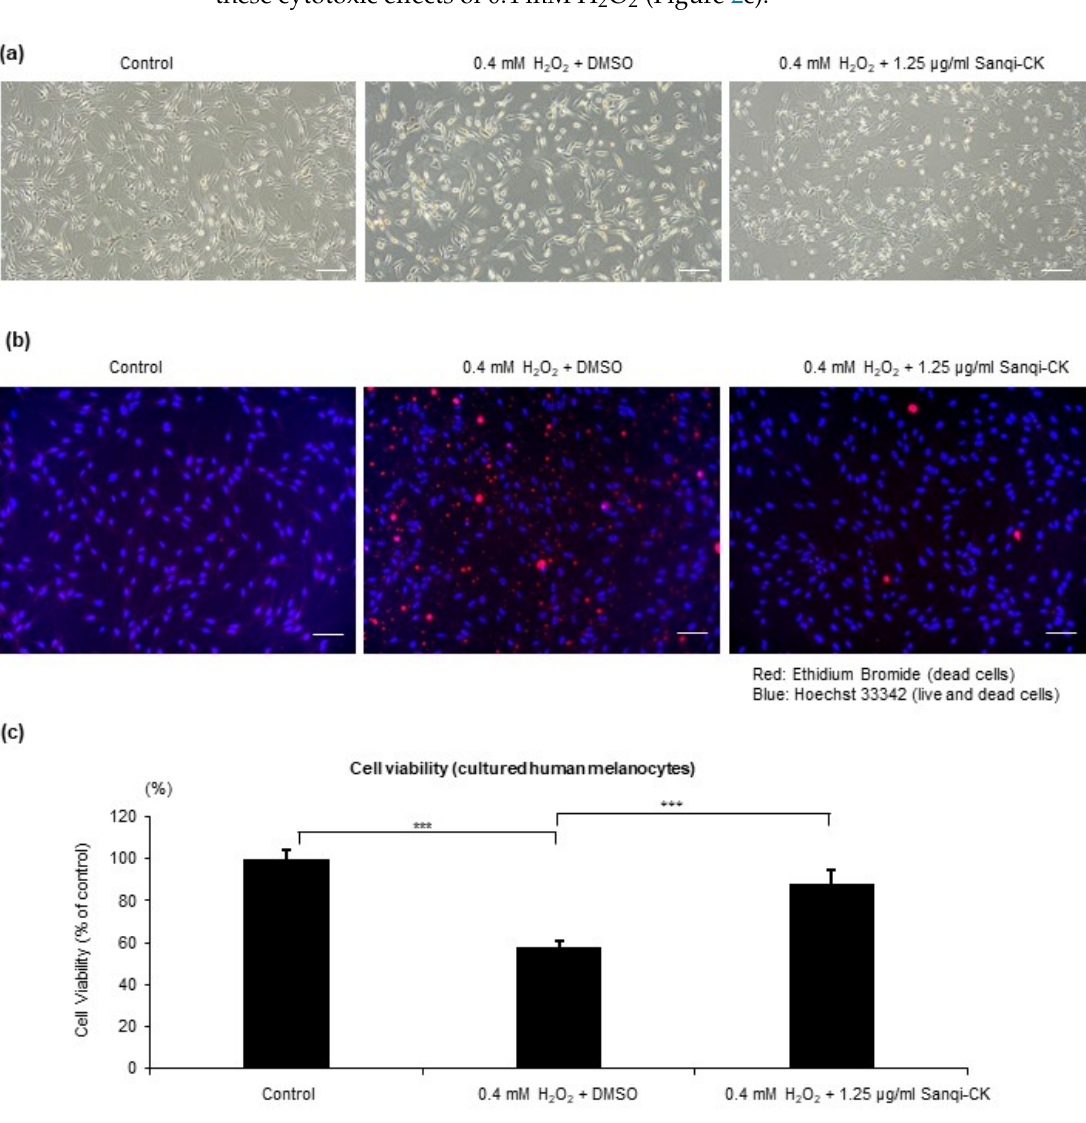
Figure 2. Protective effects of Sanqi-CK on cell survival of cultured human epidermal melanocytes (HEMn-MPs) against H 2 O 2 treatment. The cells were pretreated with a nontoxic concentration of Sanqi-CK (1.25 µ g/mL) for 6 h, followed by 0.4 mM H 2 O 2 treatment for an additional 24 h. After these treatments, ( a ) melanocyte morphology was observed with bright-field microscopy; ( b ) cell staining was performed with ethidium bromide (red) and Hoechst 33342 (blue) and observed using confocal fluorescence microscopy; and ( c ) cell viability was evaluated by the MTT assay. White bar in ( a , b ), 50 μ m. Data in ( c ) represent the results of three independent experiments and are shown as mean ± SD. *** p < 0.01; difference between the indicated two groups by Student’s t -test.